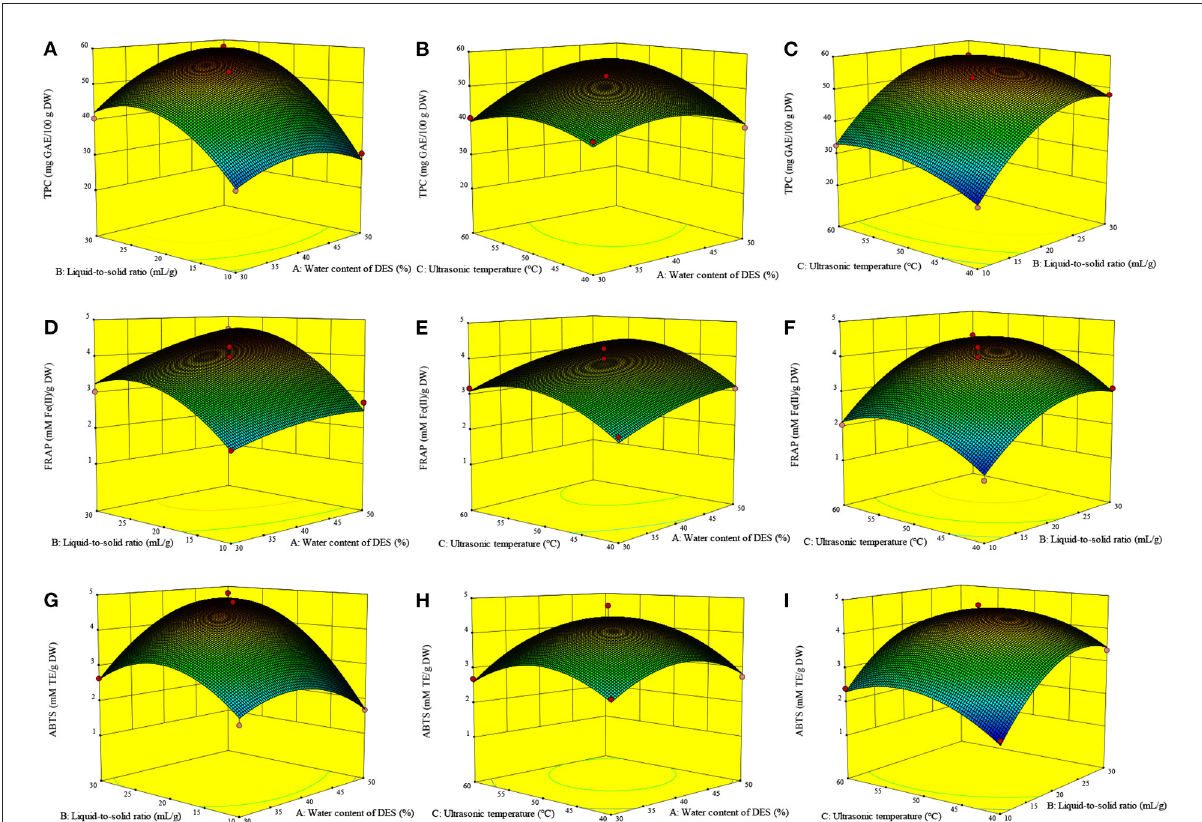
FIGURE3 Interactive effects of the variables on the TPC (A–C) , FRAP (D–F) and ABTS (G–I) of Asparagopsis taxiformis extracts. Interactive effects of water content of DES and liquid-to-solid ratio on TPC (A) ; Interactive effects of water content of DES and ultrasonic temperature on TPC (B) ; Interactive effects of liquid-to-solid ratio and ultrasonic temperature on TPC (C) ; Interactive effects of water content of DES and liquid-to-solid ratio on FRAP (D) ; Interactive effects of water content of DES and ultrasonic temperature on FRAP (E) ; Interactive effects of liquid-to-solid ratio and ultrasonic temperature on FRAP (F) ; Interactive effects of water content of DES and liquid-to-solid ratio on ABTS (G) ; Interactive effects of water content of DES and ultrasonic temperature on ABTS (H) ; Interactive effects of liquid-to-solid ratio and ultrasonic temperature on ABTS (I)